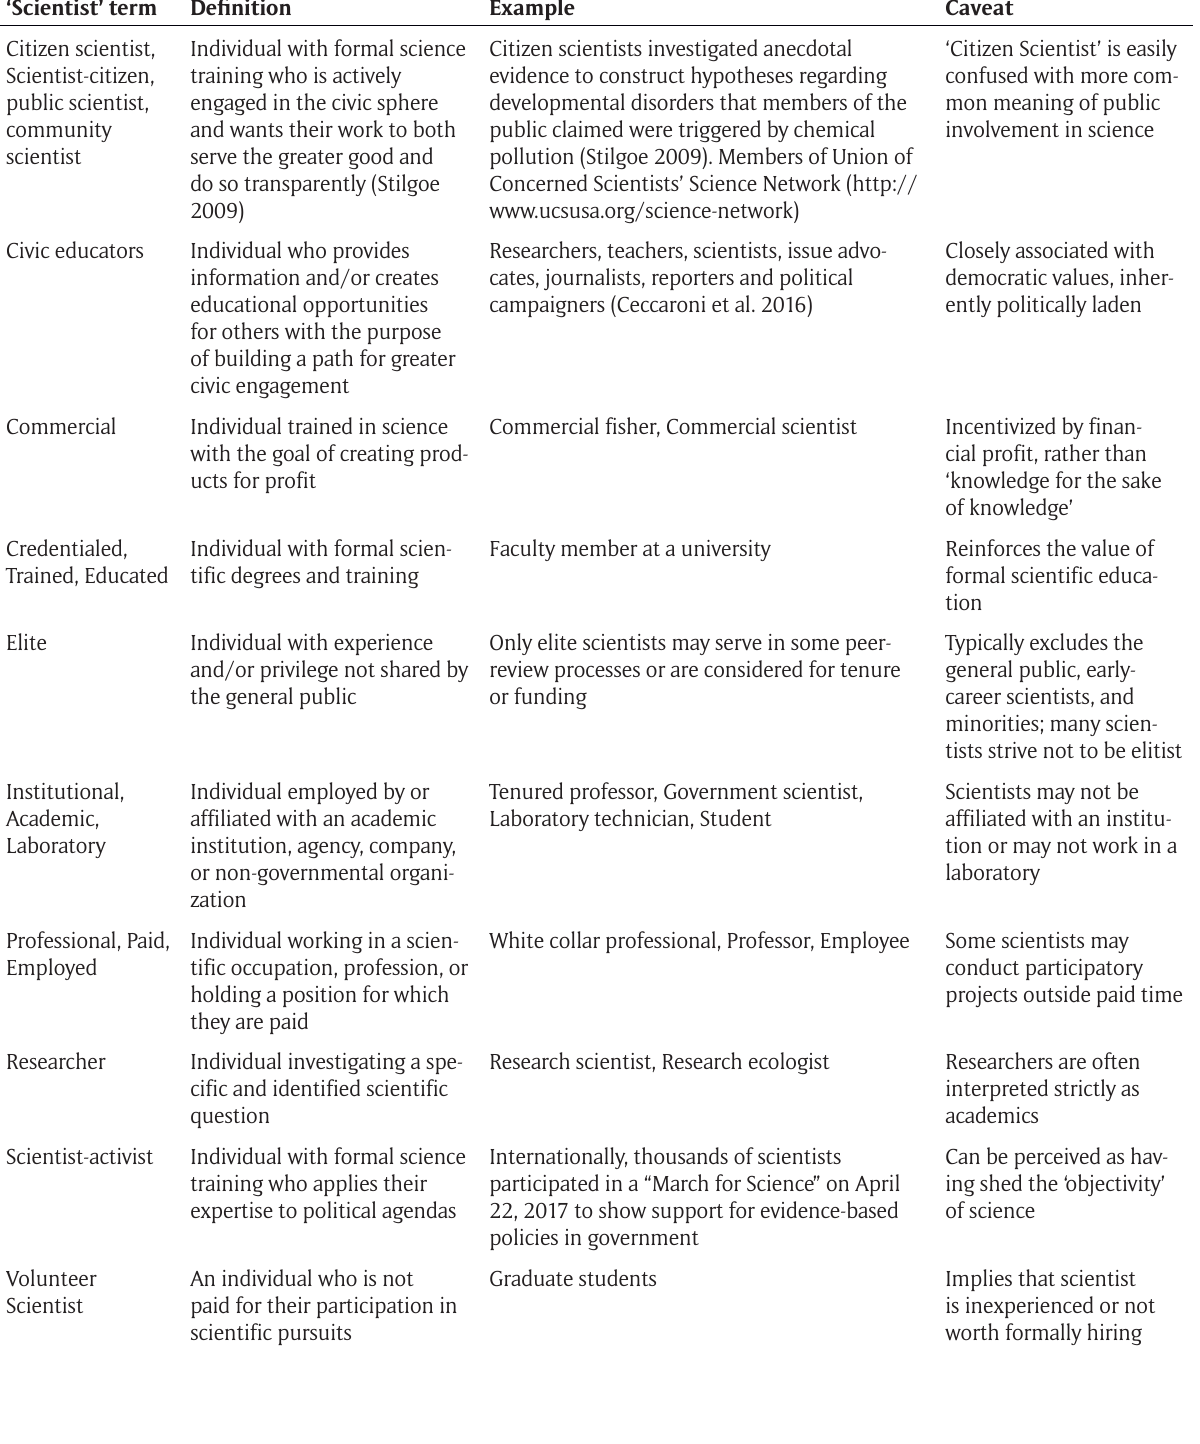
Table 3: Terms describing scientists who work with citizens in ‘citizen science.’ ‘Scientist’